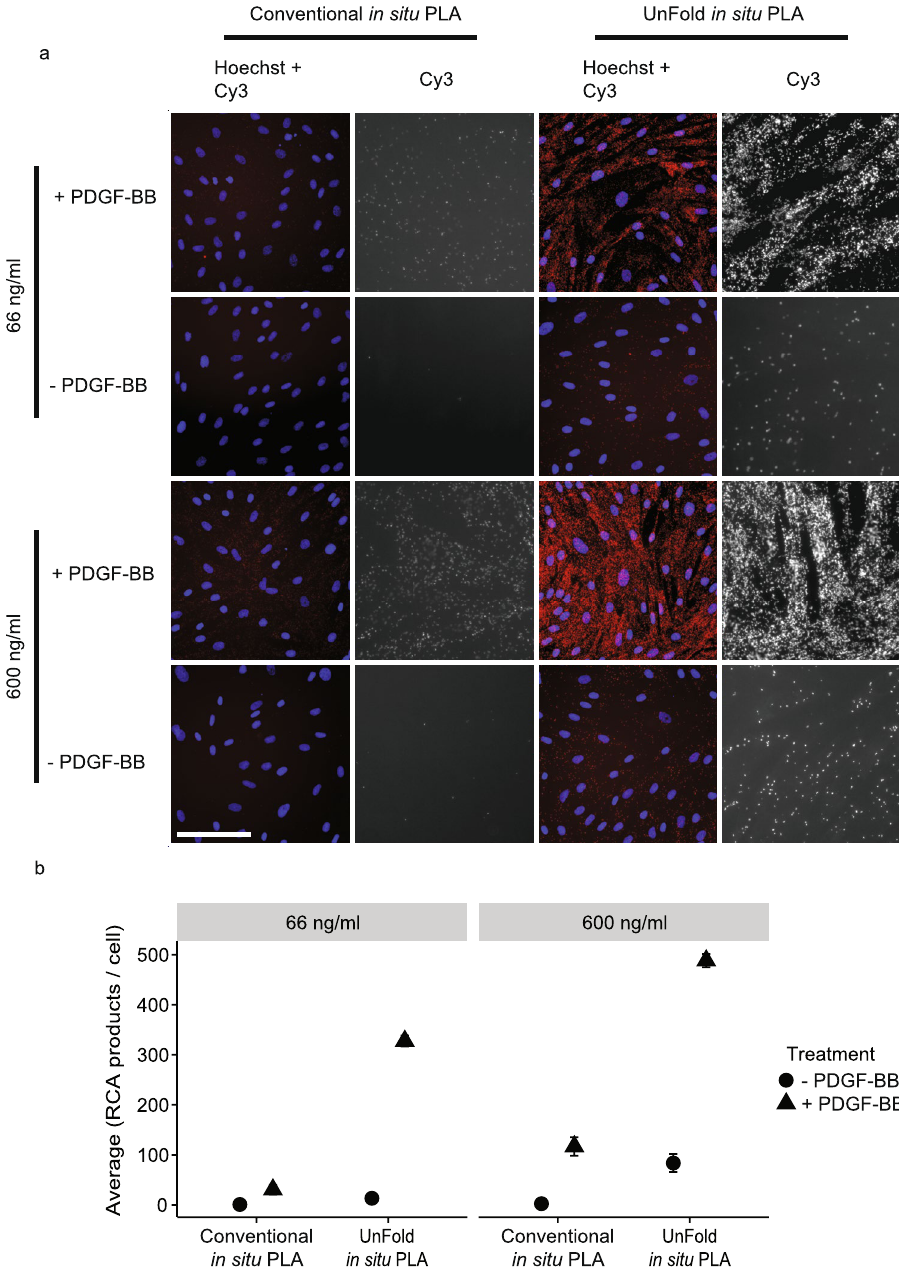
Figure 6. Visualization of phosphorylation of PDGFR- β in BJ hTert cells. ( a ) Images comparing serum-starved BJ hTert cells ( − ) versus cells treated with PDGF-BB for 45 min on ice ( + ) by detecting phosphorylation levels of the PDGFR- β (anti-PDGFR and anti-pan phosphorylation (pY100) antibodies). The RCA products were labeled with Cy3 (red dots in the merged images) and the nuclei were stained with Hoechst 33342. Scale bar (white) = 50 µ m. ( b ) Quantification of signals comparing conventional and UnFold in situ PLA at different probe concentrations. The experiment was performed four times. Five images were collected per experimental condition. Error bars represent